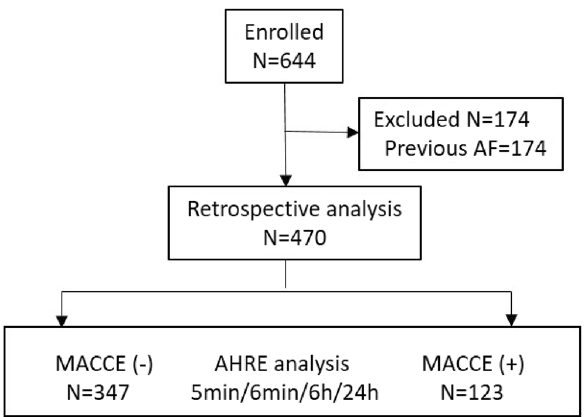
Figure 1. Development of the study cohort. Initially, 644 patients were recruited for the study; however, 174 were excluded due to a previous diagnosis of AF. Therefore, the final study cohort consisted of 470 patients, of which 123 experienced MACCE ( AF atrial fibrillation, AHRE atrial high-rate episodes, MACCE major adverse cardio/cerebrovascular events; N